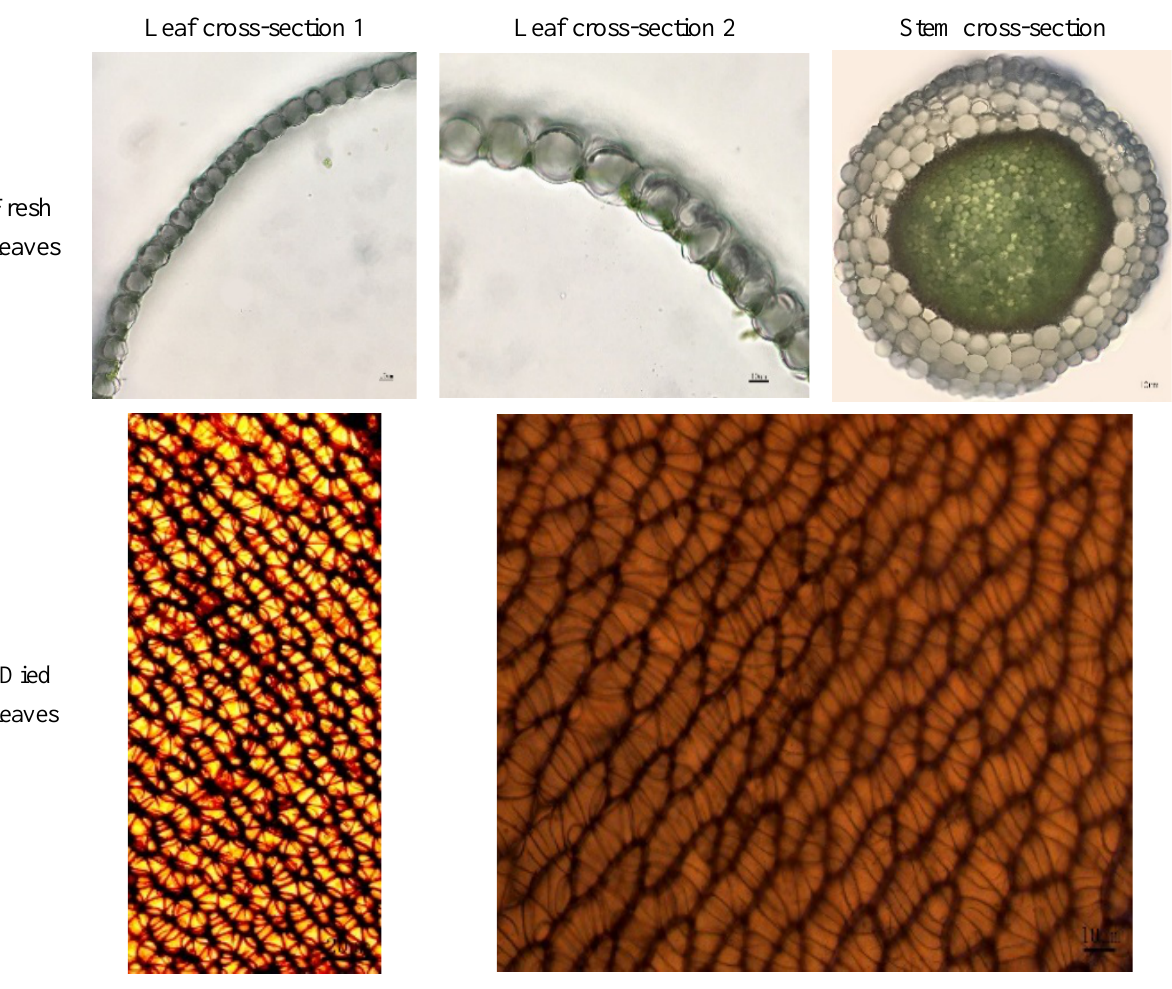
Figure 10. The cell structure of S. magellanicum samples.